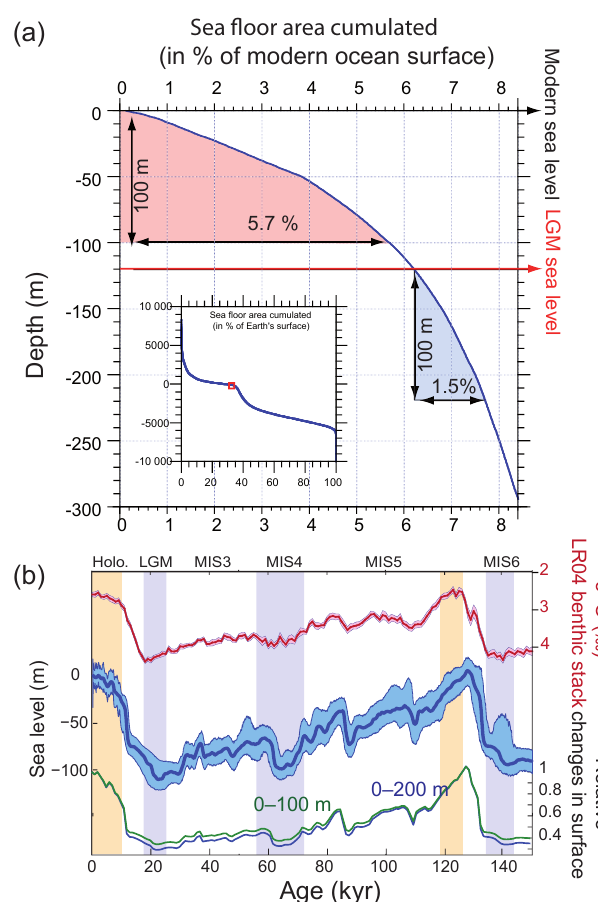
Figure 9. (a) Global hypsometric curve based on ETOPO01 (Amante and Eakins, 2009); (b) LR04 benthic stack (Lisiecki and Raymo, 2005); sea level reconstruction (Grant et al., 2012); and cal- culated changes in the surface of the 0–100 and 0–200m depth in- tervals relative to the modern situation. Vertical bars are as in Fig.